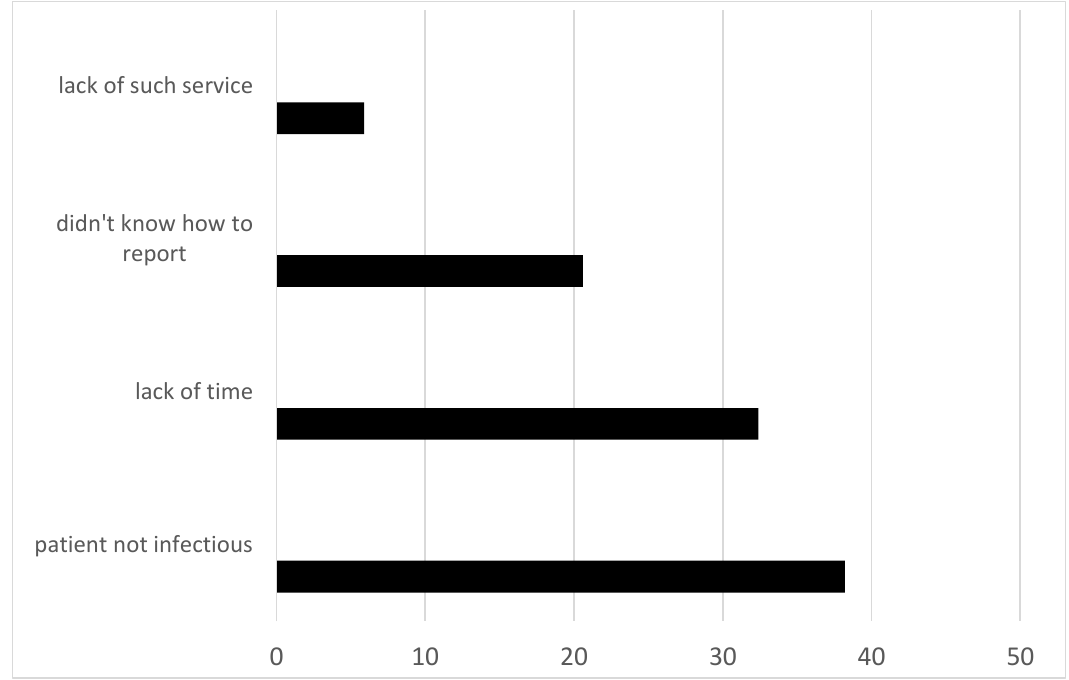
Figure 1. Reasons for not reporting exposures by paramedics; n = 286.